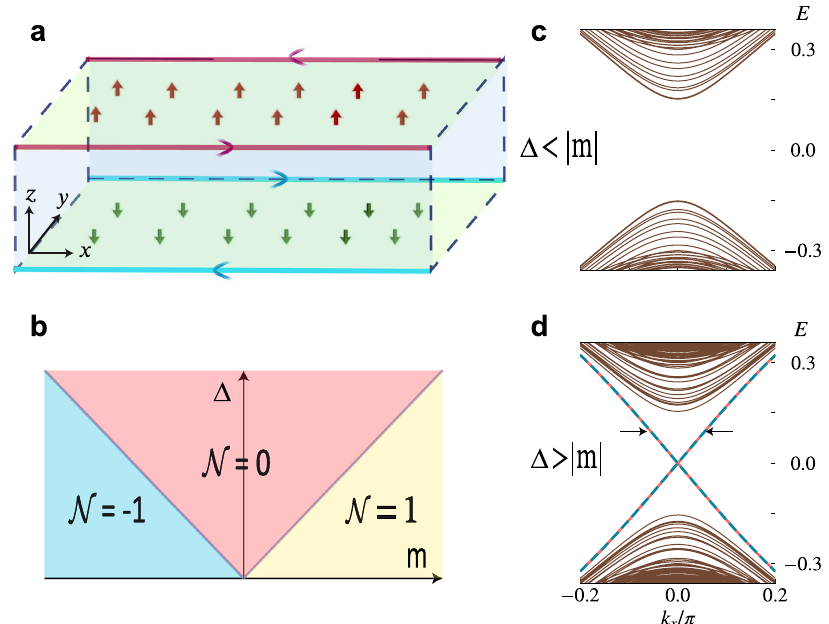
Fig. 1 Analysis of axion insulators in the Majorana basis. a Schematic diagram of an axion insulator with outward magnetization on surfaces of a 3D topological insulator and covered by s − wave superconductors on the top and bottom. Four lines with arrows represents the chiral Majorana hinge modes. b Phase diagram of one 2D surface of an axion insulator with homogenous magnetic doping m and covered by an s -wave superconductor with pairing potential Δ . c and d Band structures E − k x of the axion-insulator-based device in a . c Four surfaces are in the N ¼ 1 phase with no topological boundary for Δ < ∣ m ∣ . d Top and bottom surfaces are driven into the N ¼ 0 phase for Δ > ∣ m ∣ , leading to two-fold degenerate gapless modes which are marked with solid and dashed lines, corresponding to chiral Majorana hinge modes in a .